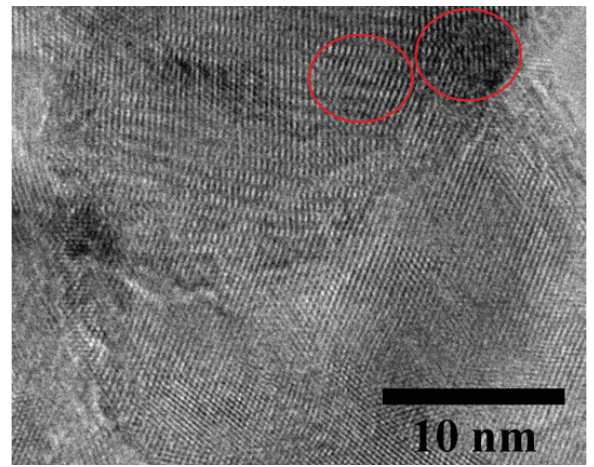
Figure 6. HRTEM image of the as-synthesized 23 nm CaF 2 nanocrystals.